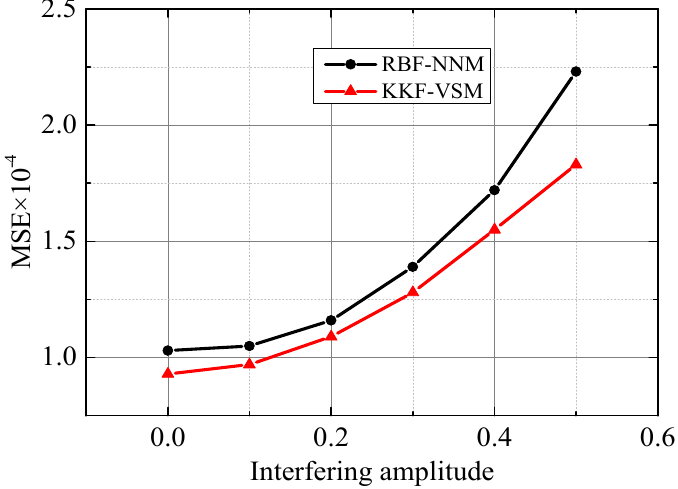
where S ( n ) is the interfering signal series with the sine wave, and A is the amplitude.